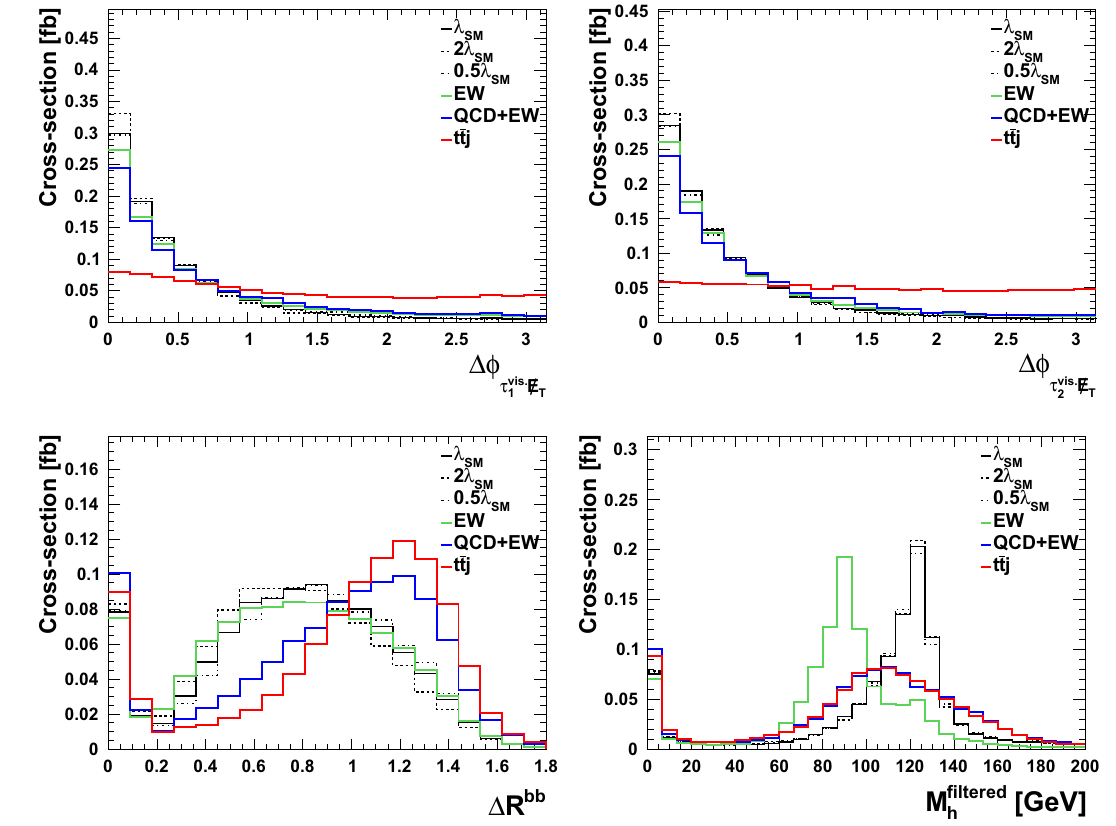
Fig. 4 Discriminating observables contributing to the boosted analysis of Sect.